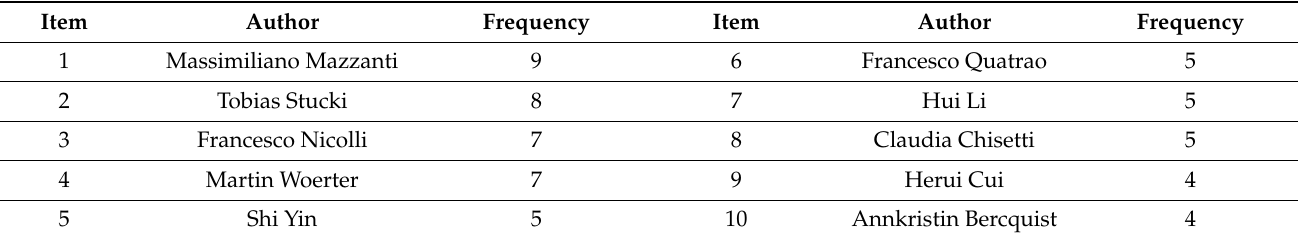
Table 2. Number of papers published by TOP 10